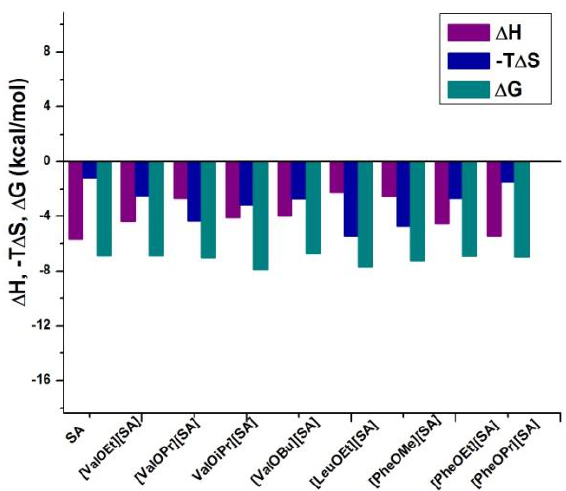
Figure 3. Contribution of the enthalpic (  H) and entropic (-T  S) terms to the Gibbs free energy (  G) of the SA and [AAOR][SA] binding to BSA (bar